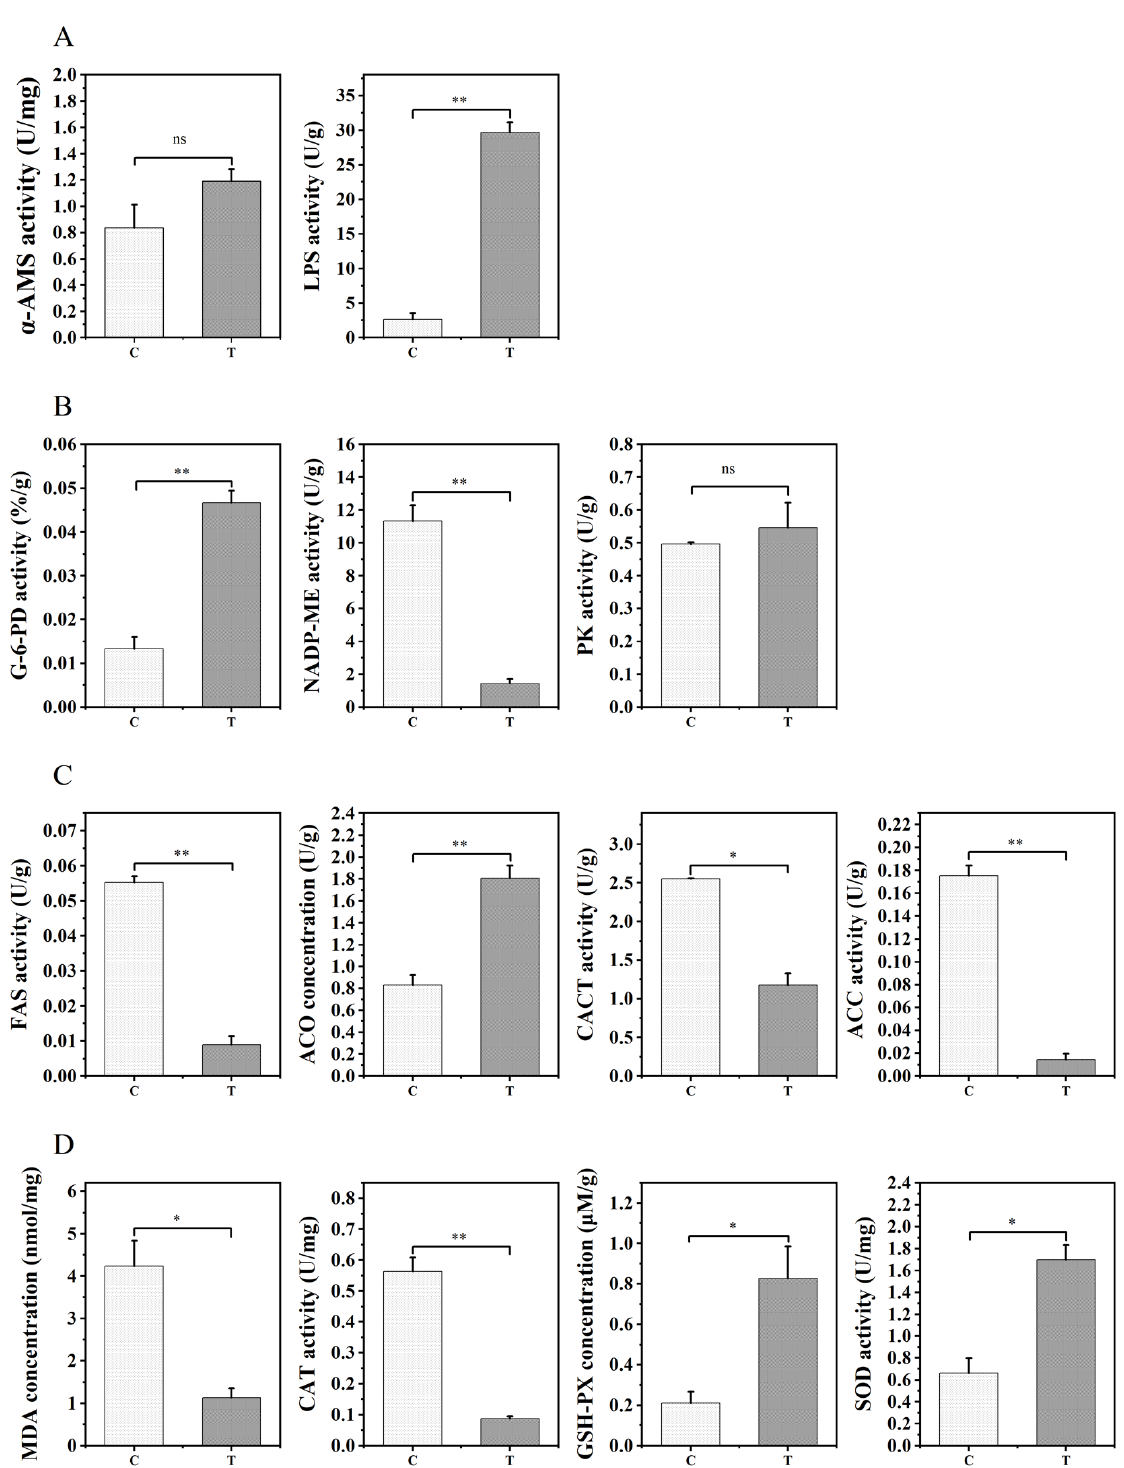
Figure 2. Comparative assessment of liver enzyme activities related to digestion ( A ), energy metabolism ( B ), lipid metabolism ( C ), and antioxidant defense ( D ) in the control group (C) and 1% TE group (T). Error bars indicate SEM ( n = 9). Asterisks indicate significant differences between the two groups (* p < 0.05, ** p < 0.01), ns: not significant ( p > 0.05) α -AMS: hepatic amylase; LPS: hepatic lipase; G-6-PD: dehydrogenase; NADP-ME: malic enzyme; PK: pyruvate kinase; FAS: fatty acid syn-